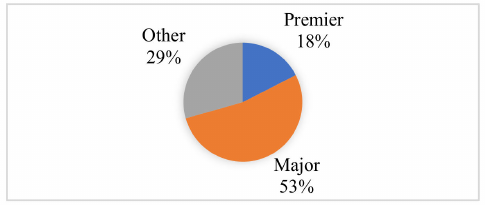
Figure 4. Breakdown of dataset papers by journal